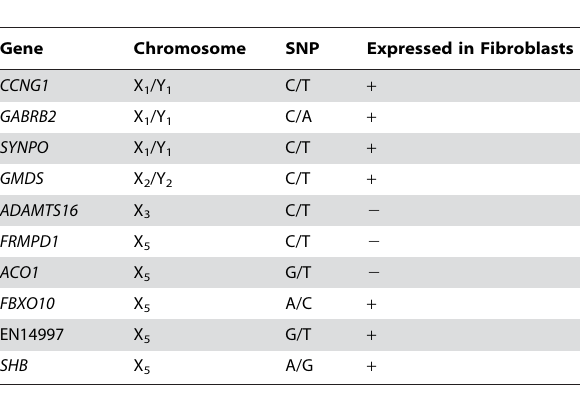
+ indicates expression detected in fibroblasts; 2 indicates no detectable expression in